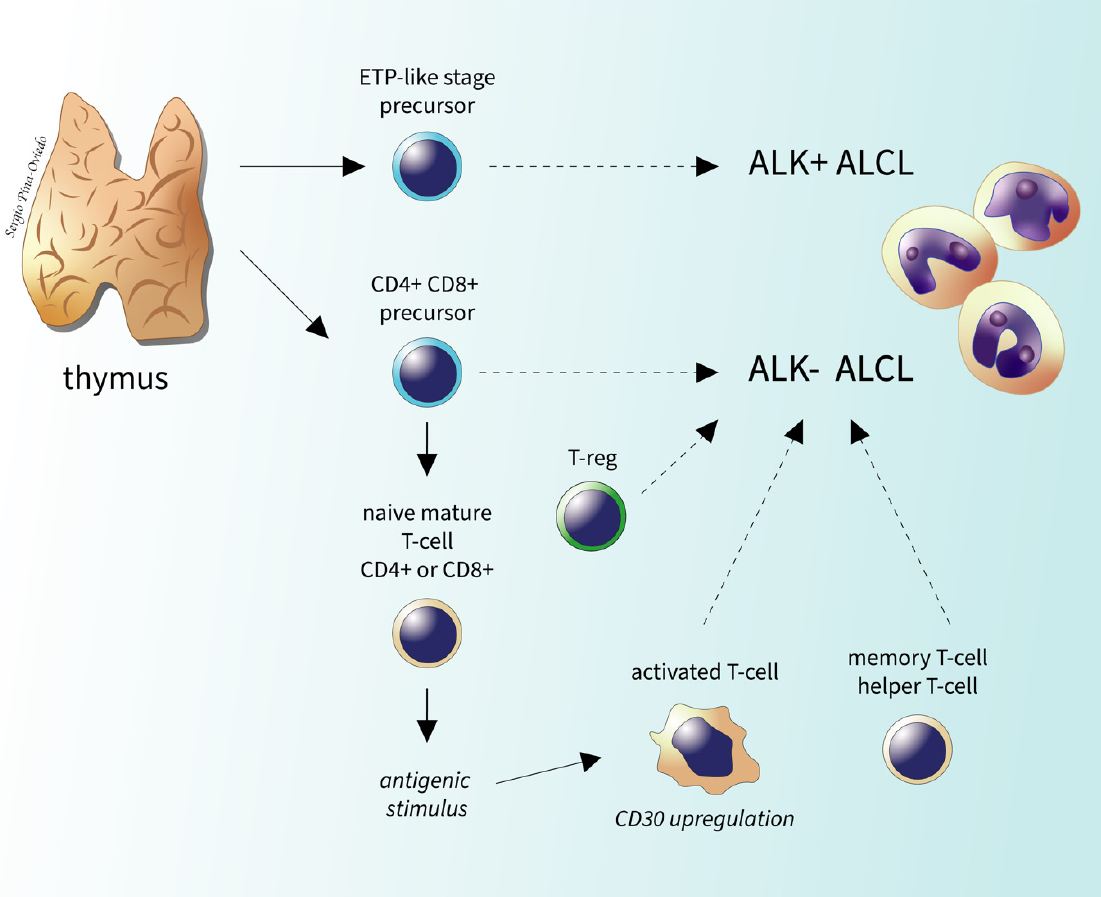
Figure 8. Putative cell(s) of origin of systemic ALCL. The methylation pattern of ALCL is similar to that of immature T-cells/thymocytes at certain stages of differentiation. ALK- ALCL has a methylation profile similar to a double-positive (CD4+/CD8+) thymic precursor. Nevertheless, multiple other subtypes of mature T-cells might also represent a potential precursor of this lymphoma (dashed arrows). ALK+ ALCL may also derive from similar mature T-cell subtypes as ALK- ALCL but this is not illustrated for simplicity.